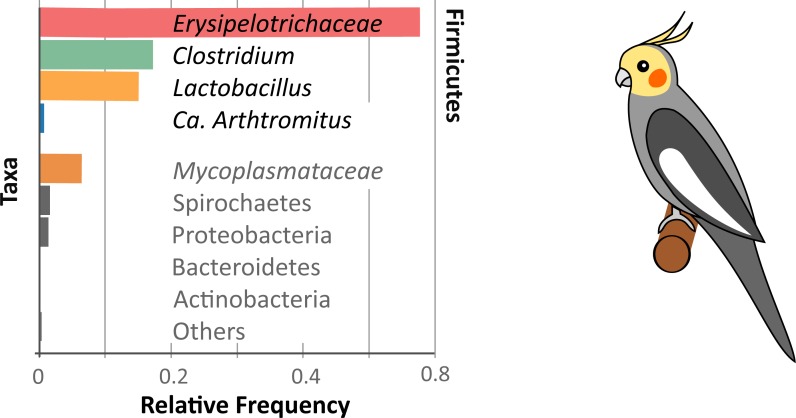
Cockatiel microbiome summary.Firmicutes dominate the microbiome diversity with Erysipelotrichaceae, Clostridium, Lactobacillus, and Ca. Arthromitus. On a lower scale is the Tenericutes phylum, with Mycoplasmataceae as the most abundant family. Other phyla such as Spirochaetes, Proteobacteria, Bacteroidetes, and Actinobacteria are barely detectable in this study.